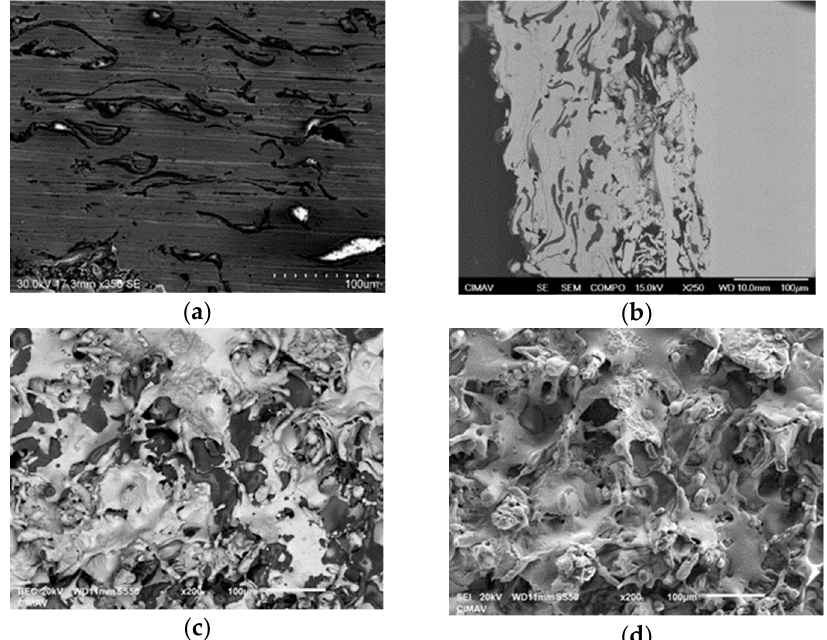
Figure 5. Application projected with a pressure of 331 kPa oxygen and 69 kPa acetylene. ( a ) and ( b ) SEM micrograph in cross-section; ( c ) and ( d ) SEM micrograph of the surface.